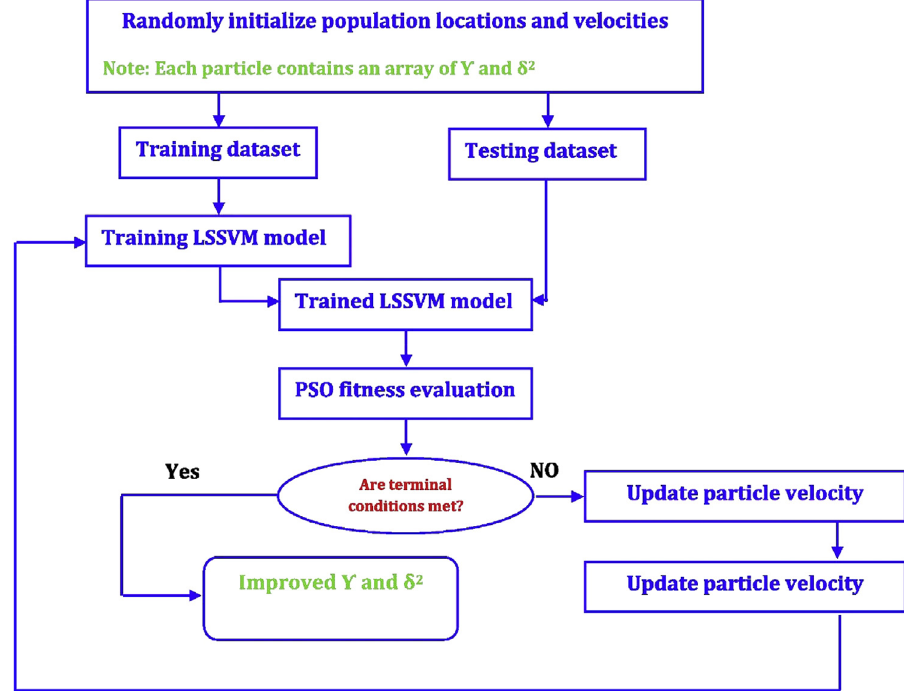
Figure 3. Schematic representation of the PSO-LSSVM method 68 .